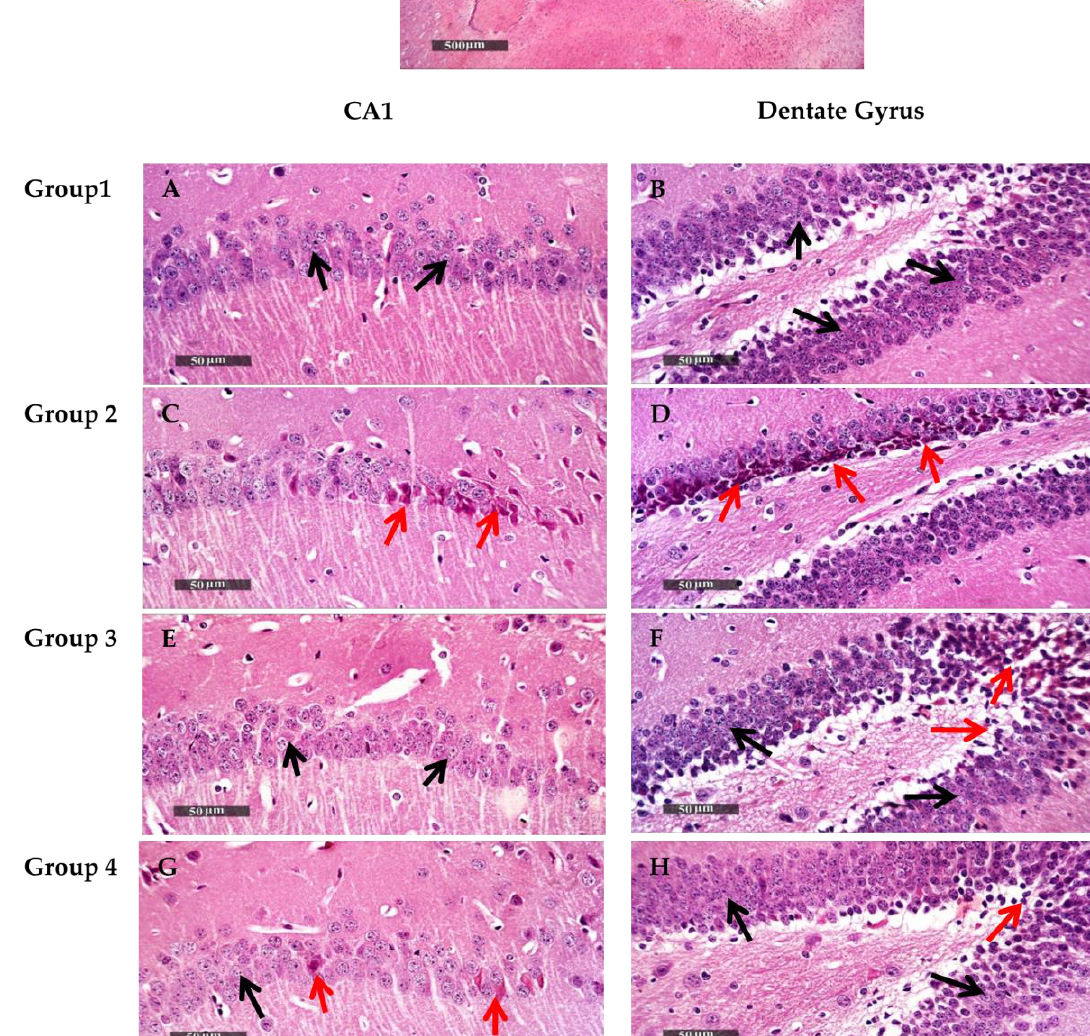
Figure 6. Anatomical overview of total hippocampal region highlighted examined fixed subregions in different groups (H&E stain, 40X; black boxed area for CA1 subregion and yellow boxed area for Den- tate Gyrus subregion). Neuroprotective histological effect of different treatments on CA1 hippocampal subregions (left column micrographs) and Dentate Gyrus subregions (Right column micrographs) with correlated groups. H&E stain, 400X. Black arrows = intact neurons, red arrows = degenerated and necrotic neurons. ( A , B ) represent group1 (negative control). ( C , D ) represent group 2 (Positive control). ( E , F ) represent group 3 (ART). ( G , H ) represent group 4 (F3).